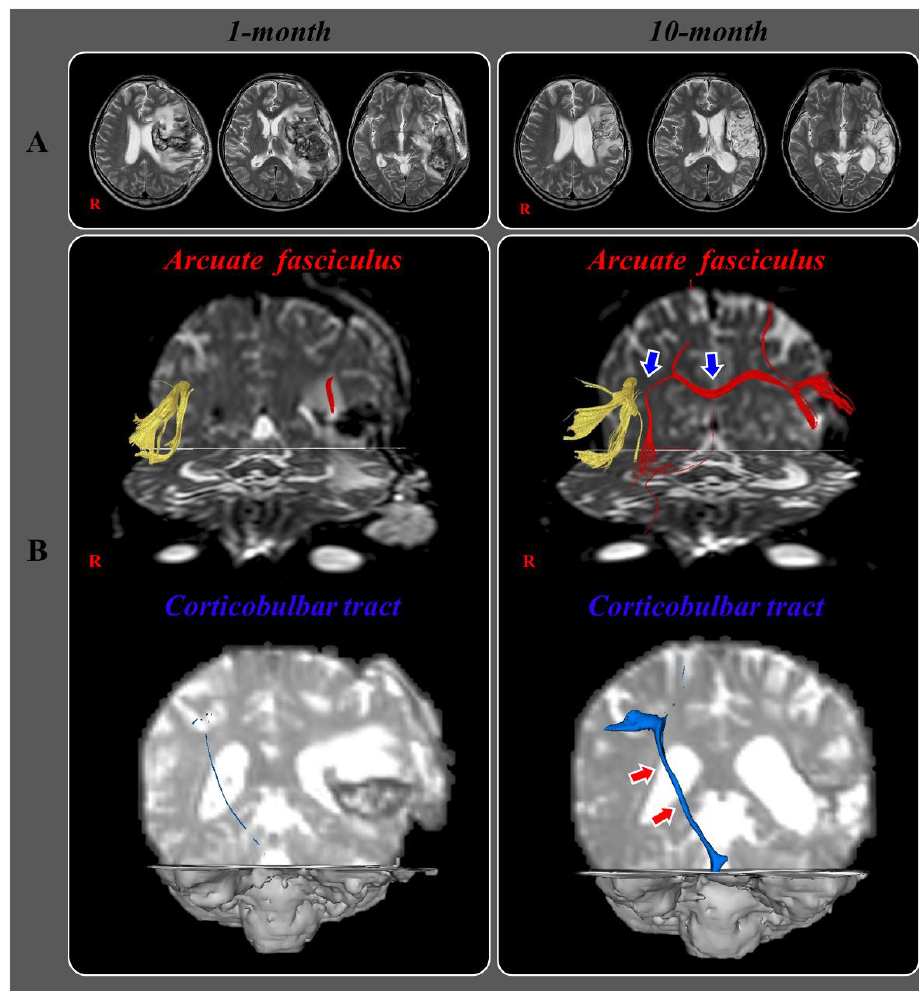
Figure 4. ( A ) Brain MR images at 1 month after onset show an infarct in the left middle cerebral artery territory, hemorrhagic transformation and subfalcine herniation. Brain MR images at 10 months after onset reveal leukomalactic lesions in the left fronto-parieto-temporo-occipital areas (R: right). ( B ) Results of diffusion tensor tractography (DTT) for the arcuate fasciculus (AF) and corticobulbar tract (CBT). On 1-month DTT, the discontinuation of the left AF and severe narrowing of the right CBT are observed. By contrast, on 10-month DTT, the left AF is connected to opposite AF by a new tract that passed through the splenium of corpus callosum (blue arrows) and the right CBT become thicker (red arrows) (reprinted with permission from Ref. [28]).